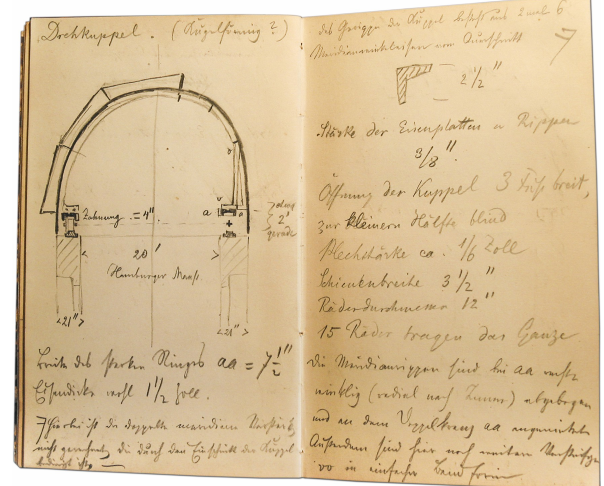
Figure 3. Helmert’s observation book, Hamburg Observatory at Millerntor (Stw/Observatory Hamburg: Sternwarte Hamburg- Bergedorf, Archiv Bibliothek, Beobachtungsbücher F. R. Helmert).